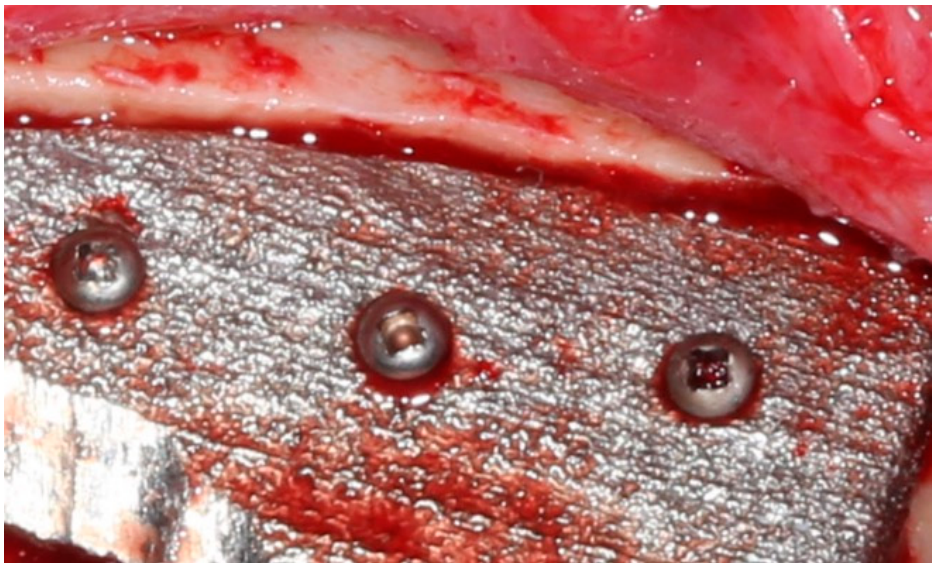
Figure 5. Secondary mandible reconstruction with porous titanium implant.